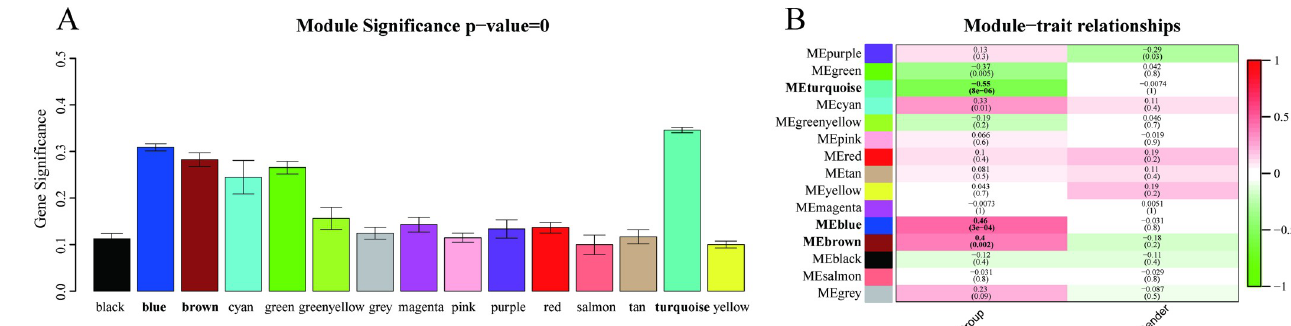
Fig 3. Identification of key modules. (A) The distribution of average gene significance and errors are shown for the modules associated with IA rupture. The turquoise, blue, and brown modules were identified as key modules. (B) A heatmap was generated to show correlations between module eigengenes and various clinical characteristics (e.g., gender and group). Corresponding correlation coefficients and P-values are also provided. Associated P-values for the turquoise, blue, and brown modules are indicated in parentheses and significant values are presented in bold font.